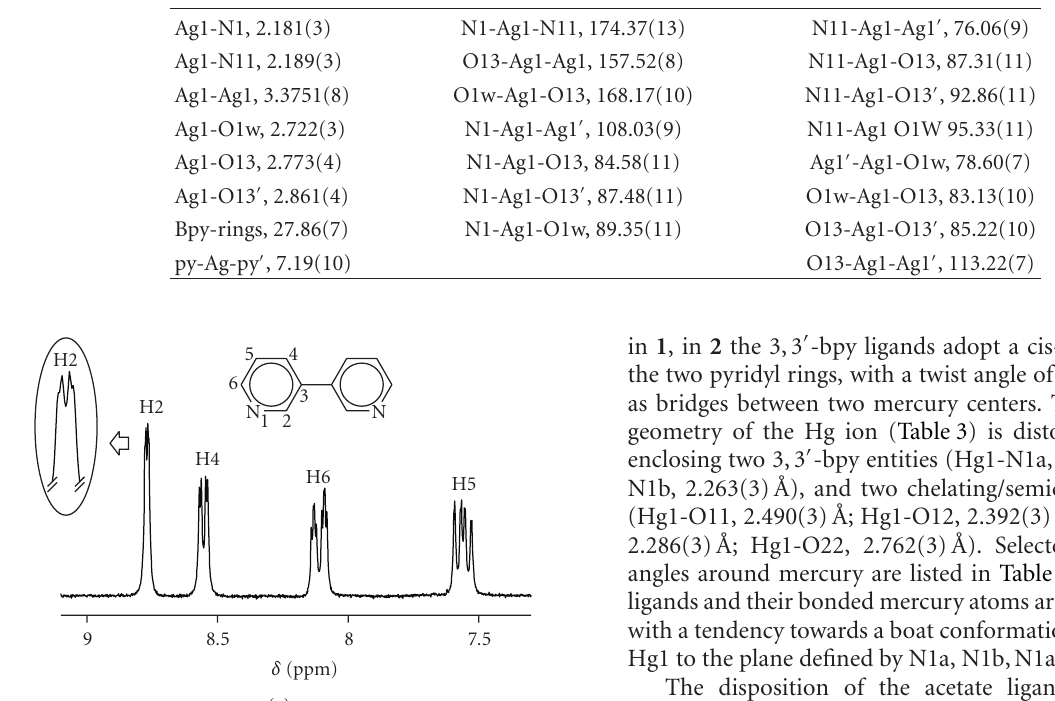
Table 2: Selected bond distances ( ˚A) and angles ( o ) for compound 1 .